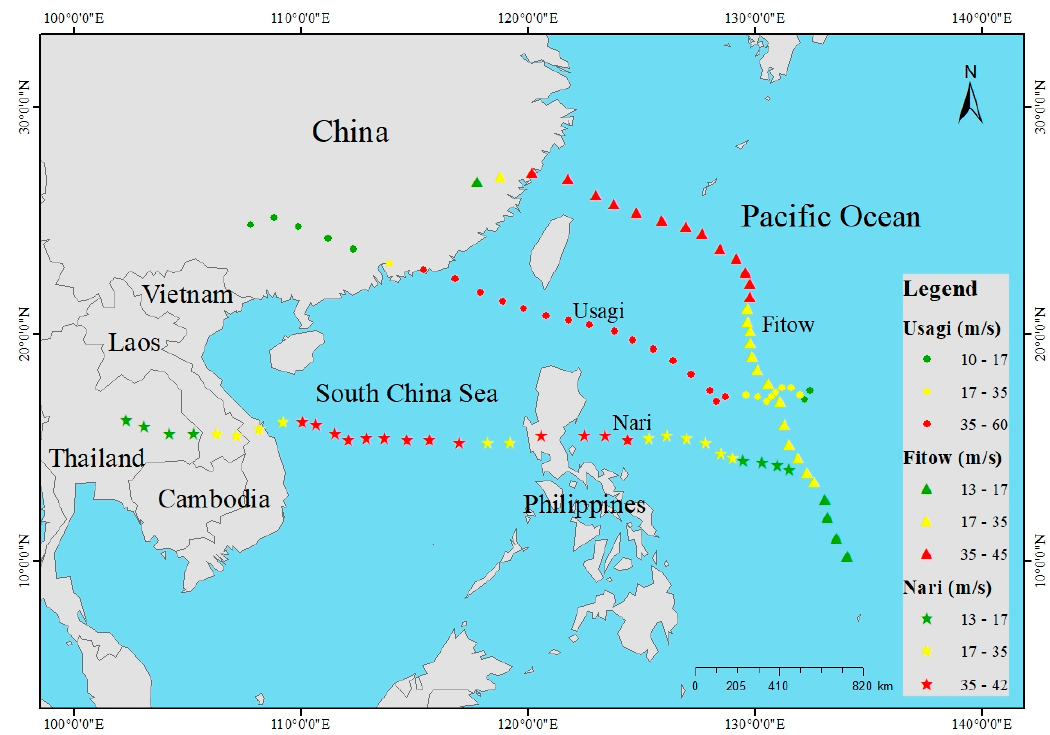
Figure 1. The moving tracks and intensity of typhoons Usagi, Fitow, and Nari.